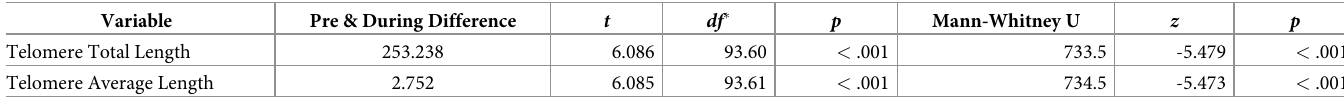
Table 5. Results of parametric and non-parametric tests of pre- vs. during pandemic telomere lengths. Variable Telomere Average